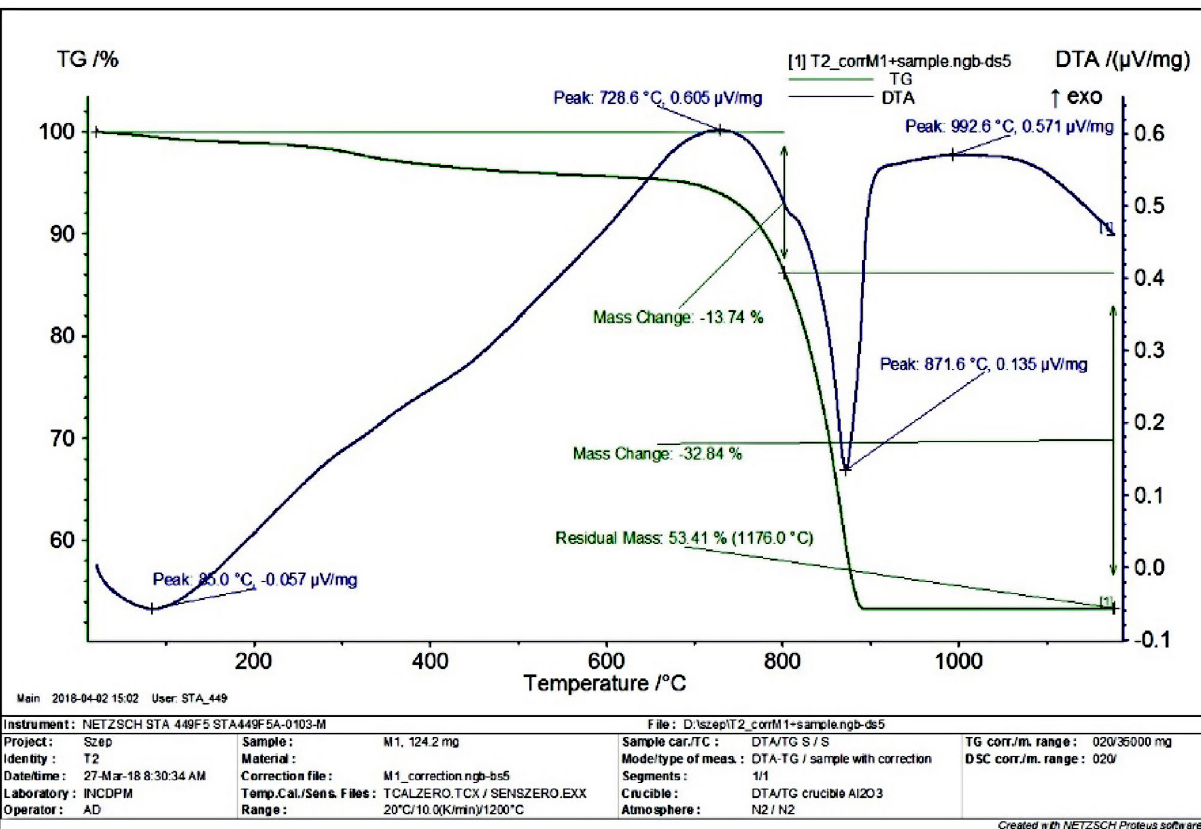
Figure 1. Thermogravimetric measurements (Created with NETZSCH Proteus software): TG – Thermogravimetry, DTA – Differential Thermoan-